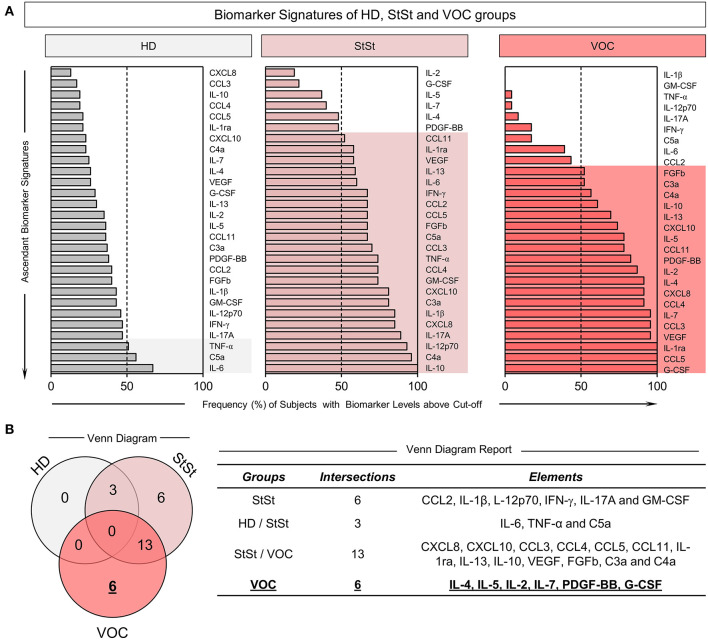
Immunological molecules in VOC clinical condition of SCA patients presented in a Venn diagram. (A) Ascendant Biomarker Signature of HD, StSt and VOC groups based on frequency of subjects with biomarker levels above Cut-off. (B) Venn Diagram with respective groups, intersections, and elements reported as potential hallmarks. The elements describe which molecules are potential hallmarks for each clinical condition and controls. Molecules were measured using Luminex and CBA. The global median for each soluble molecule was calculated and used as a cut-off point in order to classify groups as low (<50%) or high (>50%) producers of chemokines, cytokines, growth factors and anaphylatoxins. HD, healthy donors; StSt, steady-state; VOC, vaso-occlusive crisis.